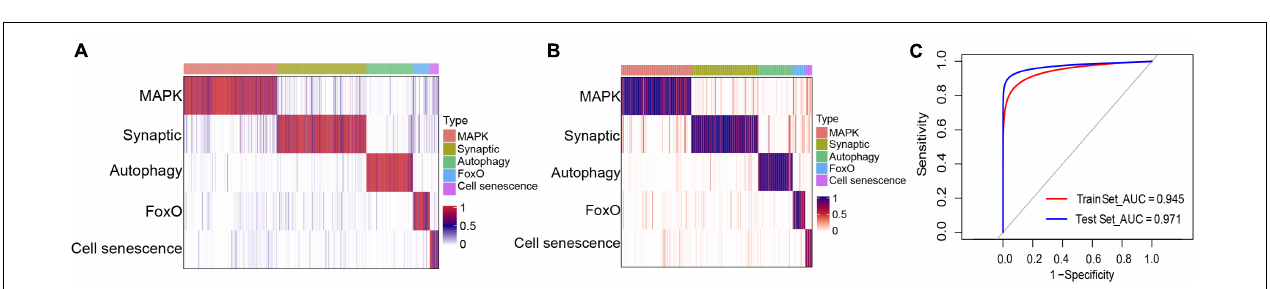
FIGURE 8 | Classifier construction for the identification of different molecular subtypes of Alzheimer’s disease. (A,B) Matrix heat maps showing the classification performance with the (A) training and (B) test datasets. (C) Receiver operating characteristic curve analysis of the training and test